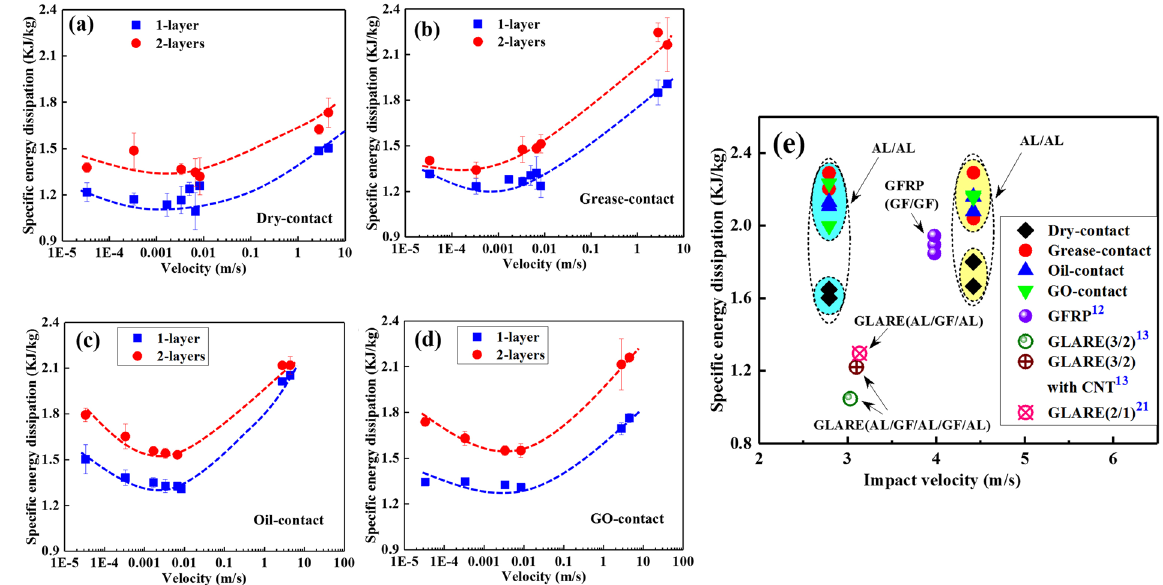
Figure 6. Specific energy dissipation of single and double layers for ( a ) dry-contact, ( b ) grease-contact, ( c ) oil- contact, ( d ) GO-contact and ( e ) the comparison between